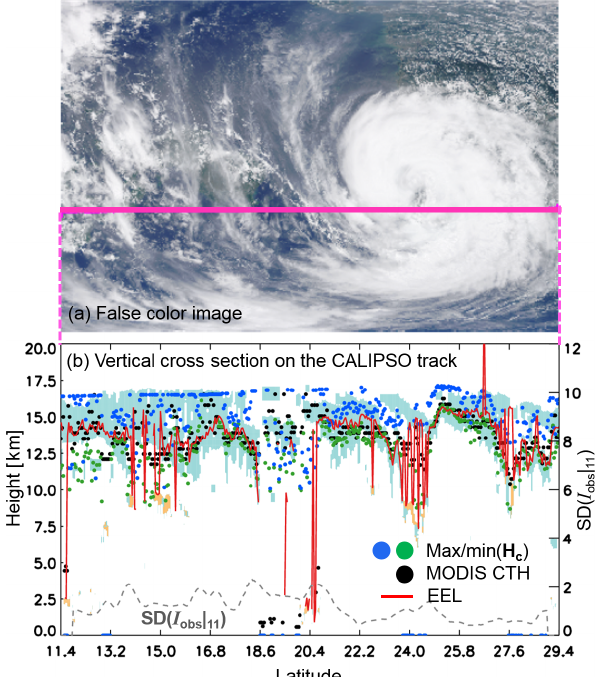
Figure 8. (a) MODIS false color image (rotated 90 ◦ left) at 05:20UTC on 8 August 2015. This scene captures part of Typhoon Goni. The heavy pink line on the image shows the CALIPSO track the closest to MODIS observation time. (b) Vertical cross section of the CALIPSO track designated by the heavy pink line in Fig. 8a. The vertical feature mask is shown as sky-blue and orange contours (randomly and horizontally oriented ice and water). The red solid line shows where the layer COT (integrated Q e at 532nm from CALIOP) reaches a value of 0.5. The green–blue and black cir- cles are the min–max( H c ) and MODIS CTH, respectively. The gray solid (dashed) line on the right-side y axis is the column COT from CALIOP (standard deviation of 11µm radiances from MODIS).